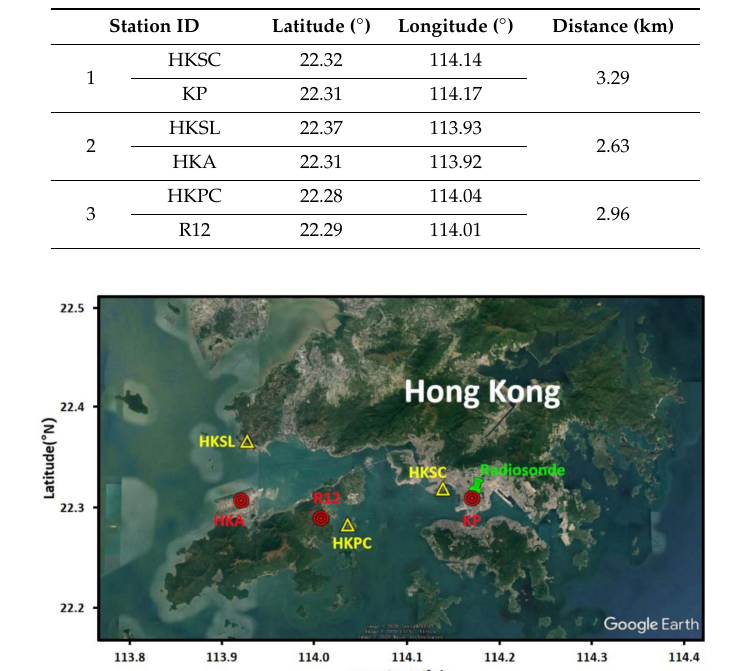
Table 1. Location of three GNSS tracking stations and their co-located weather stations selected for this study.